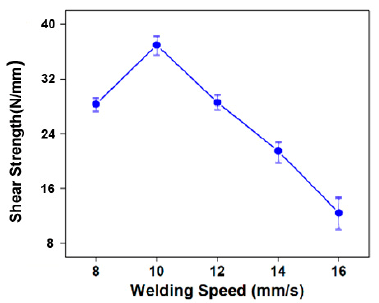
Figure 5. The relationship between the welding speed and Shear strength.